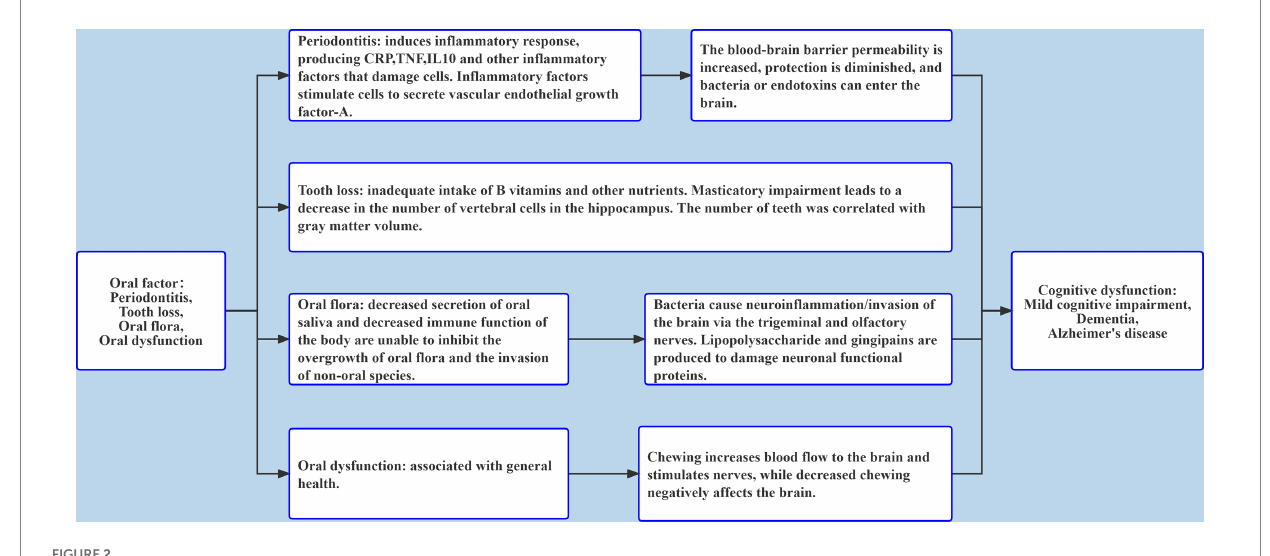
FIGURE 2 The role of oral factors including periodontitis, tooth loss, oral flora, and oral dysfunction in cognitive